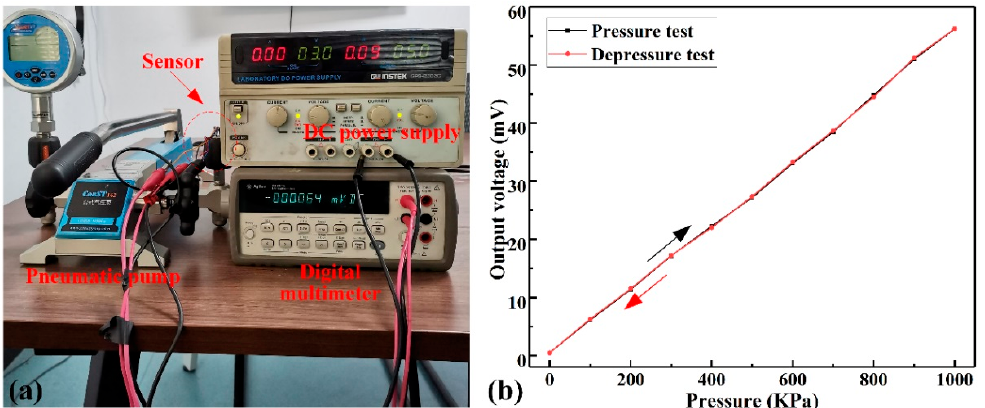
Figure 7. Performance test of the sensor at room temperature. ( a ) Pressure measuring system at room temperature. ( b ) The curve of output voltage as a function of pressure.